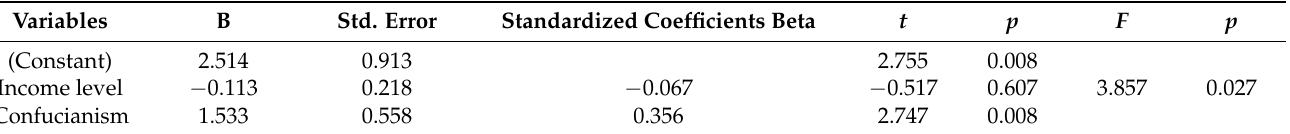
Table 4. Major factors of gender ratio of suicide rates in Confucian and European